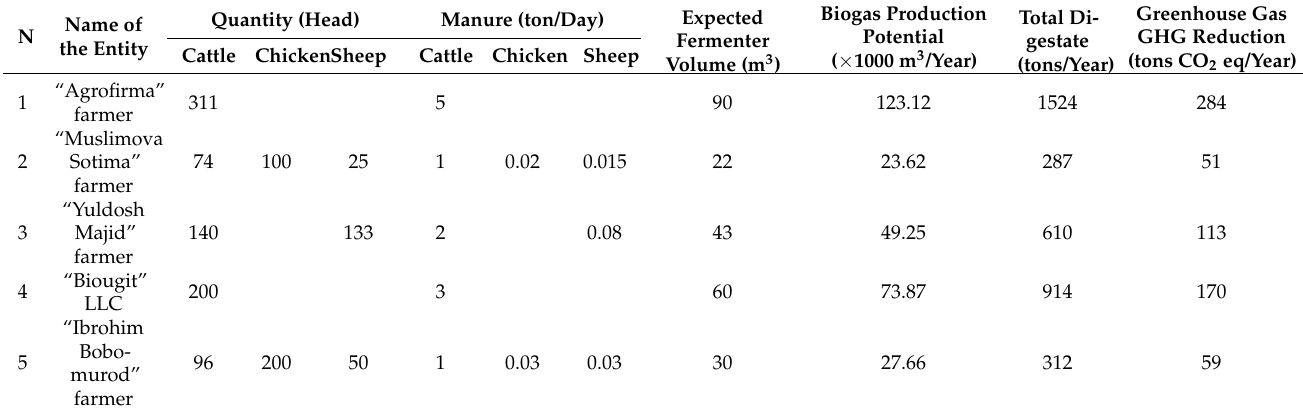
Table 1. Farmers with high interest in biogas production.